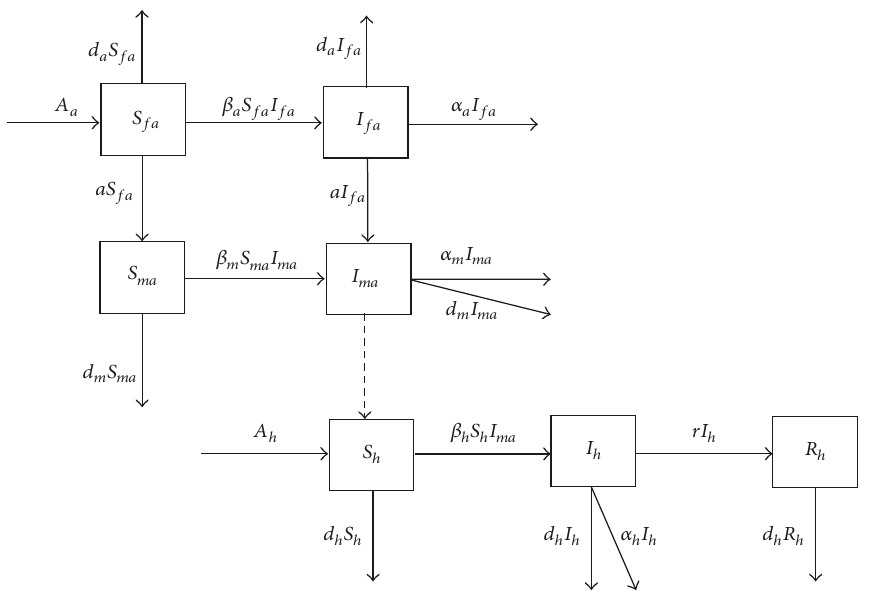
Figure 1: Flowchart of avian influenza A(H7N9)